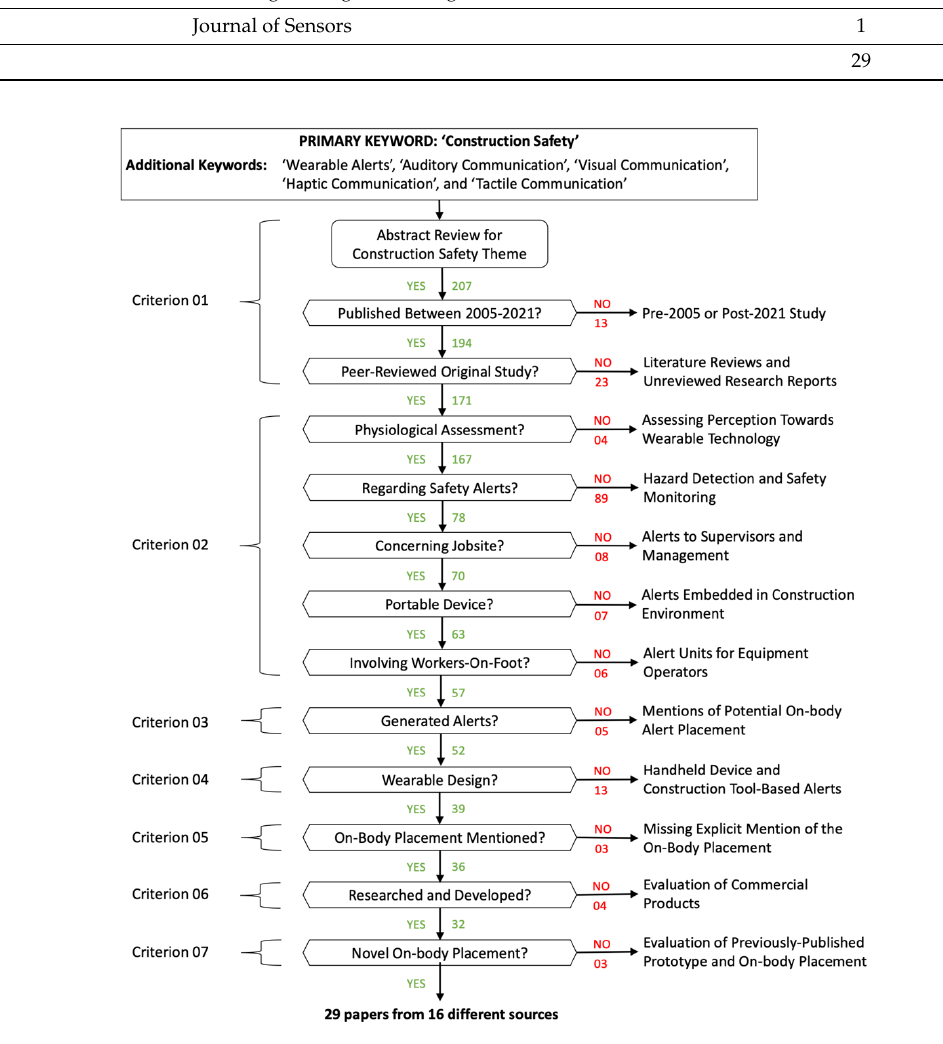
Figure 2. Overview of the review process and selection of literature.